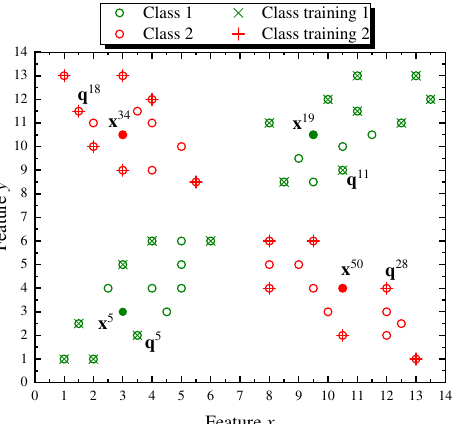
Figure 5. X-shaped dataset with 55 samples. Training points in class c 1 are marked with a cross ( × ), training points in class c 2 marked with a plus sign ( + ), and selected test points x ζ ∈ Q p , for ζ = 5,19,34,50, shown as filled colored dots. The assigned class to test points corresponds, respectively, to the class of the training points q j ∈ P p where j = 5,11,18,28.